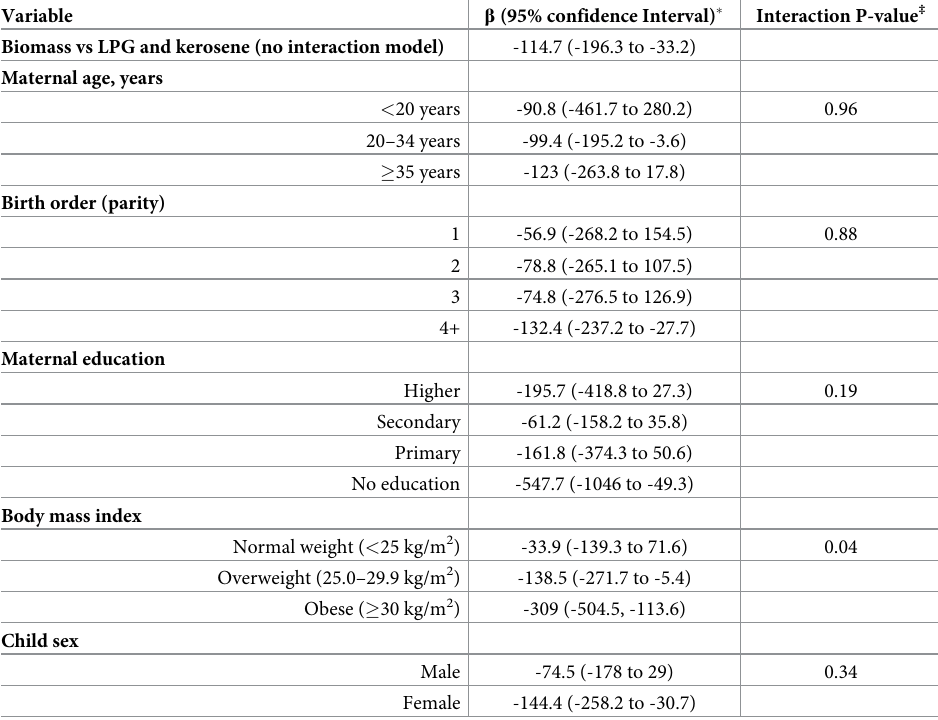
Table 3. Associations between biomass fuel and birth weight by levels of other factors in CEGROMS (N = 1514). Variable β (95% confidence Interval) � Interaction P-value ‡ Biomass vs LPG and kerosene (no interaction model) Maternal age,